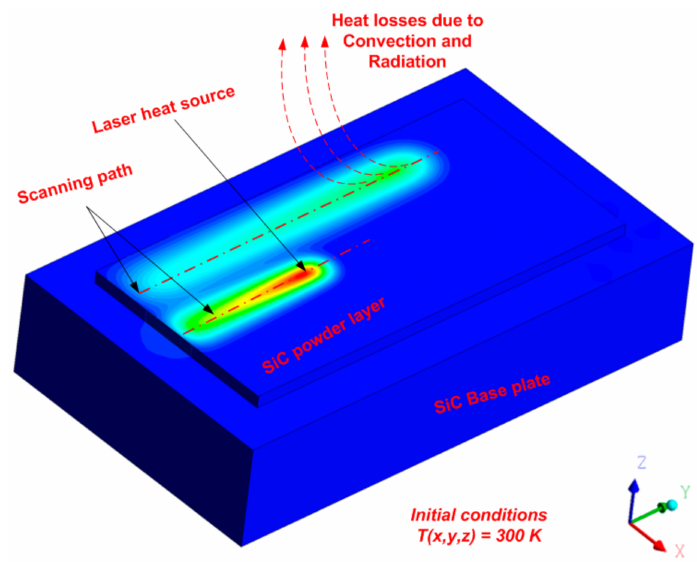
Figure 2. The initial and boundary conditions used in the model.